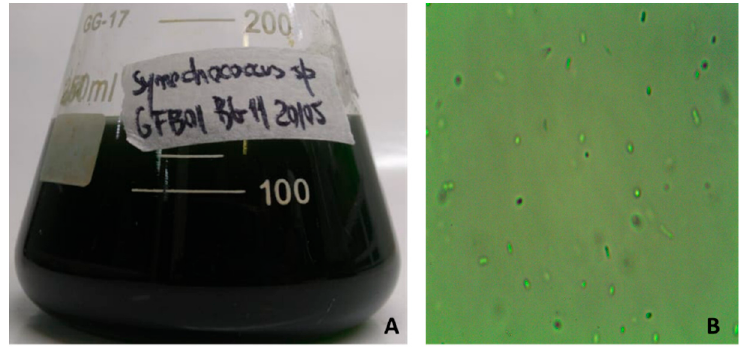
Figure 1. Synechococcus sp. GFB01 in BG11 medium ( A ) and visualized by optical microscope ( B ). Magnification: 1000× (Nikon H550L) .